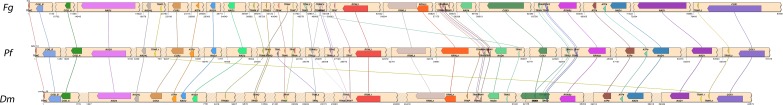
Comparisons of the mitogenomes of Pseudonectria foliicola (Pf), Dactylonectria macrodidyma (Dm) and Fusarium graminearum (Fg).Shared areas contain intergenic sequence that has been collapsed to improve diagram readability; the starting and ending coordinates are plotted at the beginning and end of these regions.